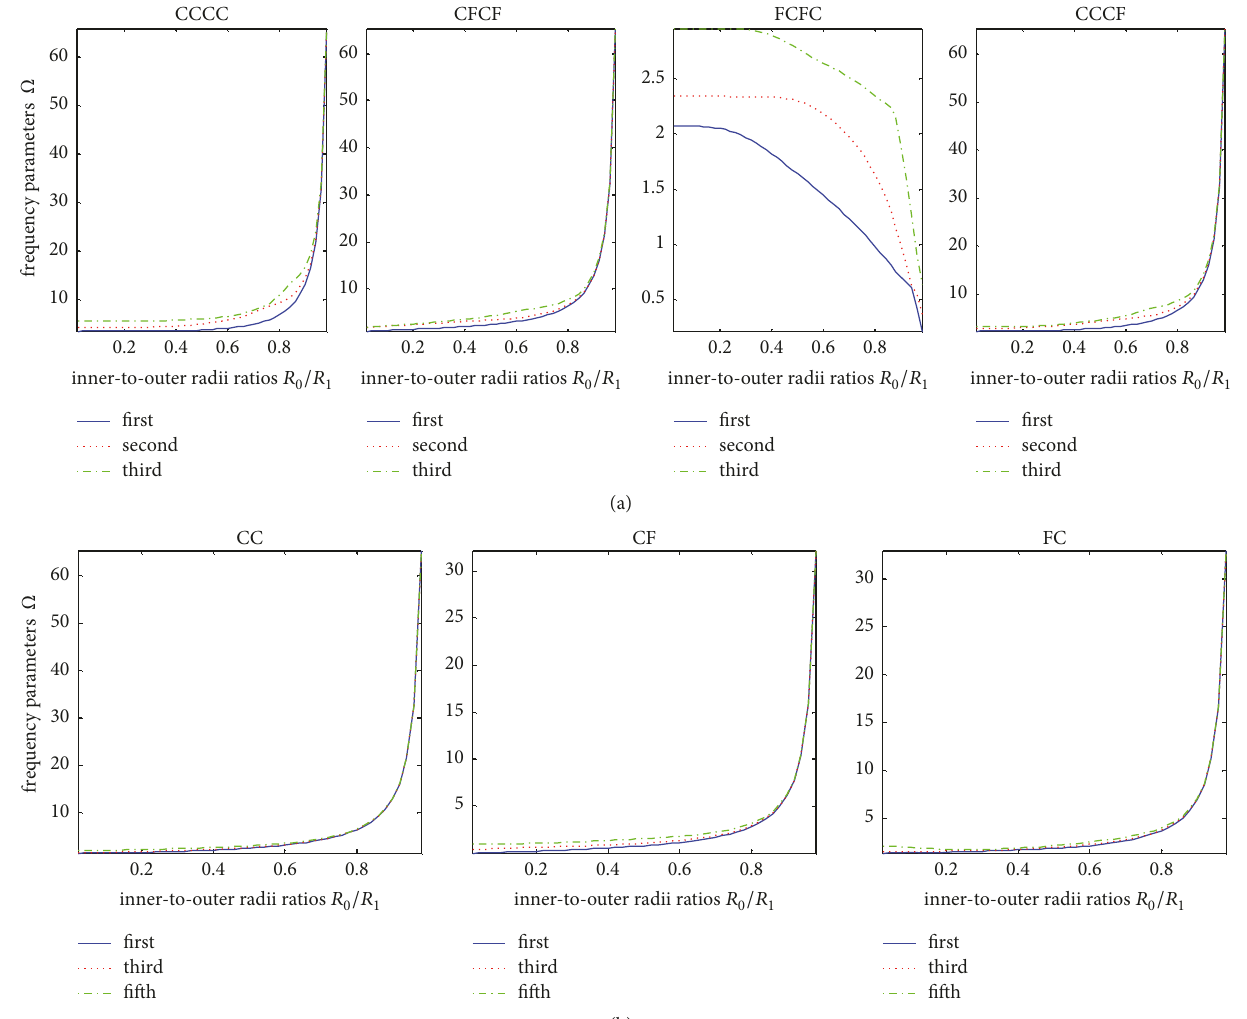
Figure 12: The variations of some frequency parameters for plates with different boundary conditions and inner-to-outer radii ratios: (a) annular sector plate; (b) annular